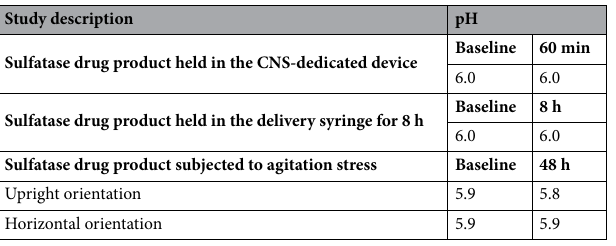
Table 2. pH robustness data of the target sulfatase during in-use and agitation